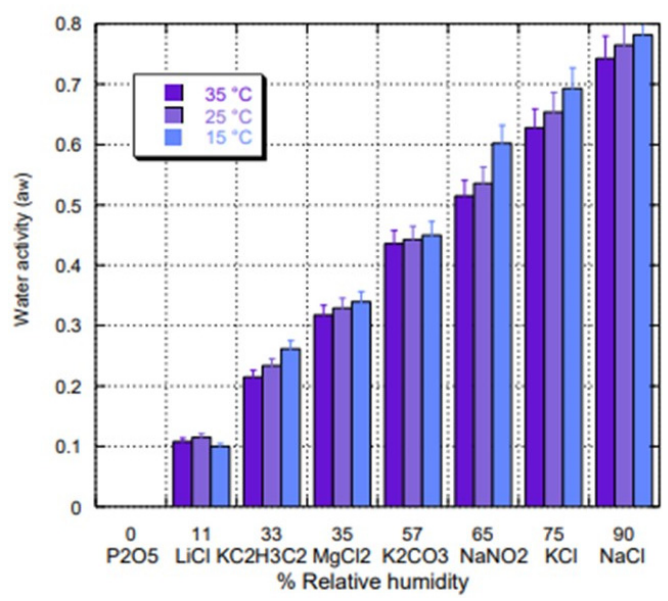
Figure 10. a w of edible film of taro starch.